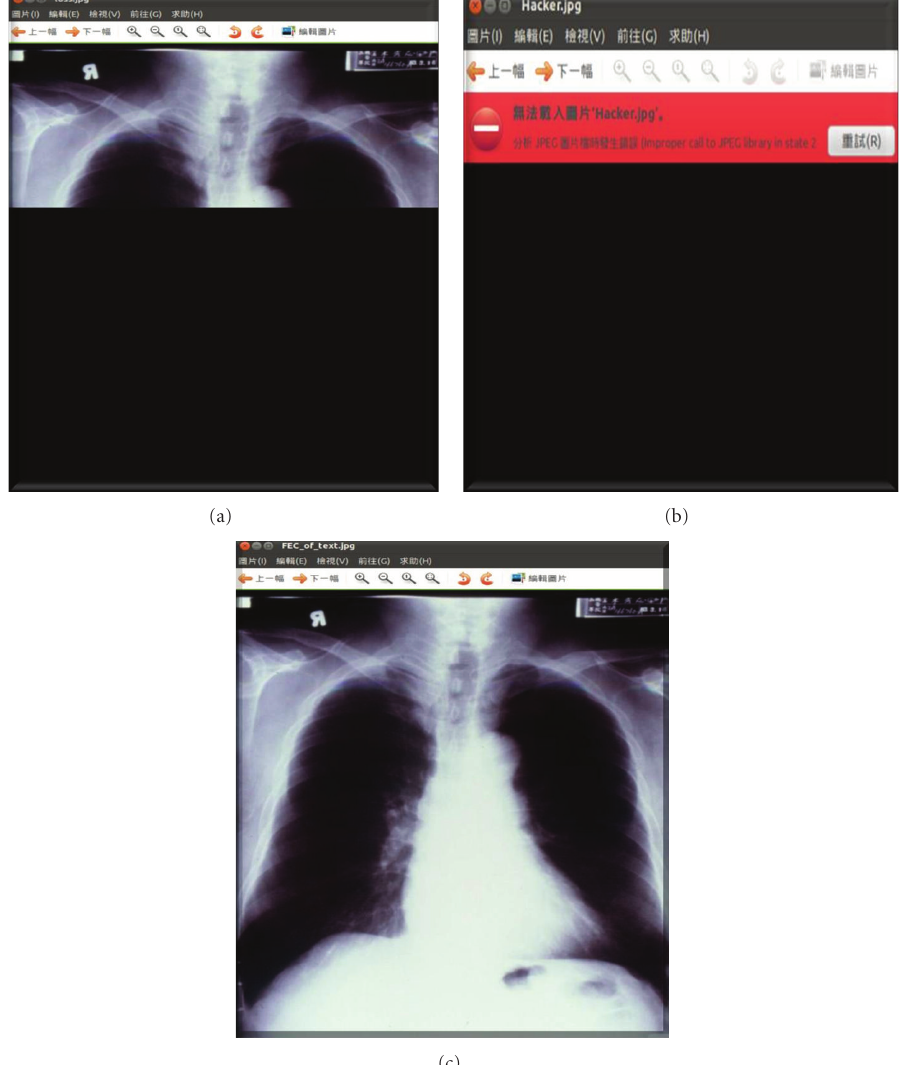
Figure 8: Snapshots of experiment results at three di ff erent receiving sides. (a) AES receiver without FEC capacity; (b) malicious receiver with FEC capacity; (c) secure FEC